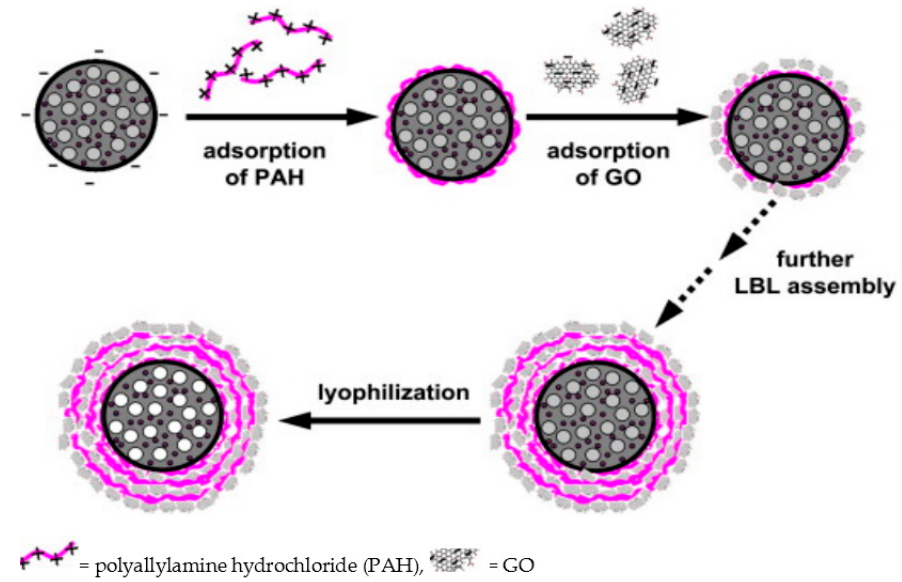
Figure 8. LBL fabrication process of Au@PLA–(PAH/GO) n microcapsule. Adapted from [148], with permission from ©2013 Elsevier.